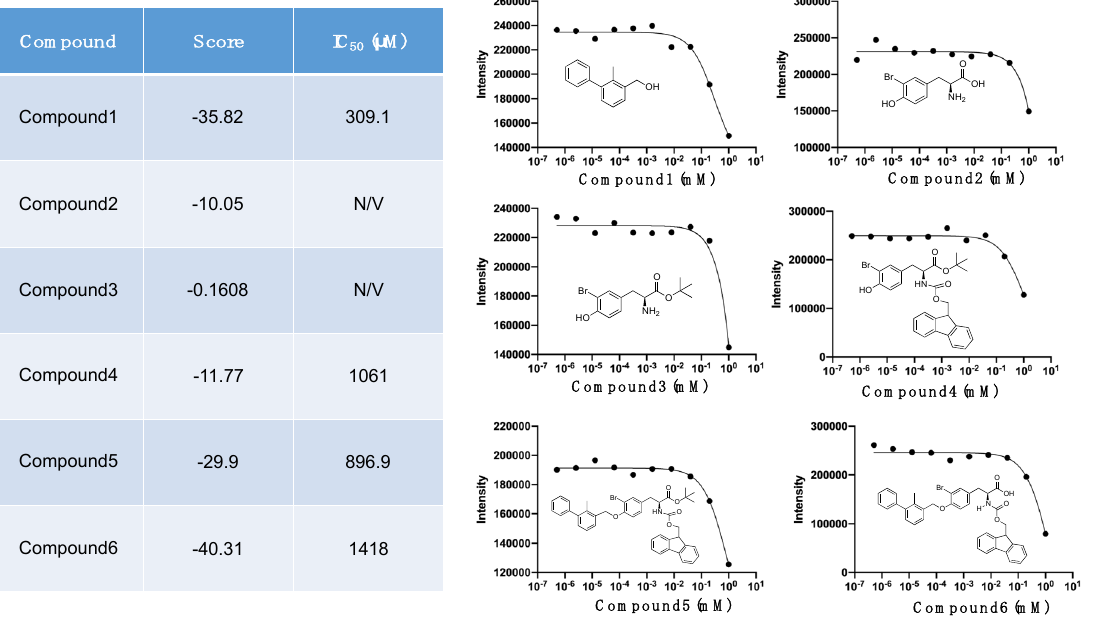
Figure 4. AlphaLISA assay of X . X shows IC 50 = 1.5 μ M with docking score = − 42.96. 2.4. Docking Simulation and Inhibition Assay of Amino-Xs The binding mode of the BMS compounds and derivatives to PD-L1 has previously been revealed by X-ray crystallography [31,40–42]. BMS compounds induces transient homodimerization of PD-L1 AB on the binding, which masks the binding site for PD-1 located in the homodimerization interface. We docked amino-X s to the crystal structure of BMS-8 /PD-L1 AB complex (PDB ID: 5J8O) [31], using ICM 3.8-7 software (Molsoft L.L.C., San Diego, CA, USA) [33–35], without guidance and induced fitting to avoid over-fitting. After the docking, we calculated the root mean square deviation (RMSD) of distances between atoms in compound BMS-8 and X , excluding C α , NH 2 , and COOH atoms (Figure 5).